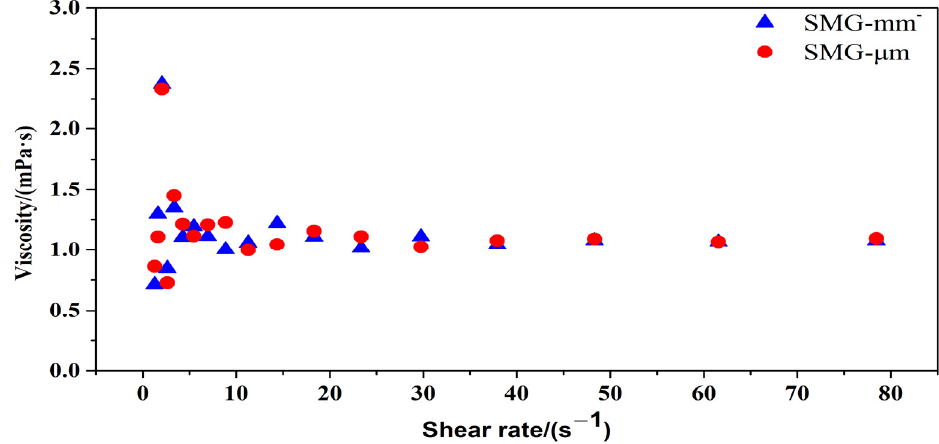
Figure 2. The relationship between the apparent viscosity of SMG aqueous dispersion and shear rate.